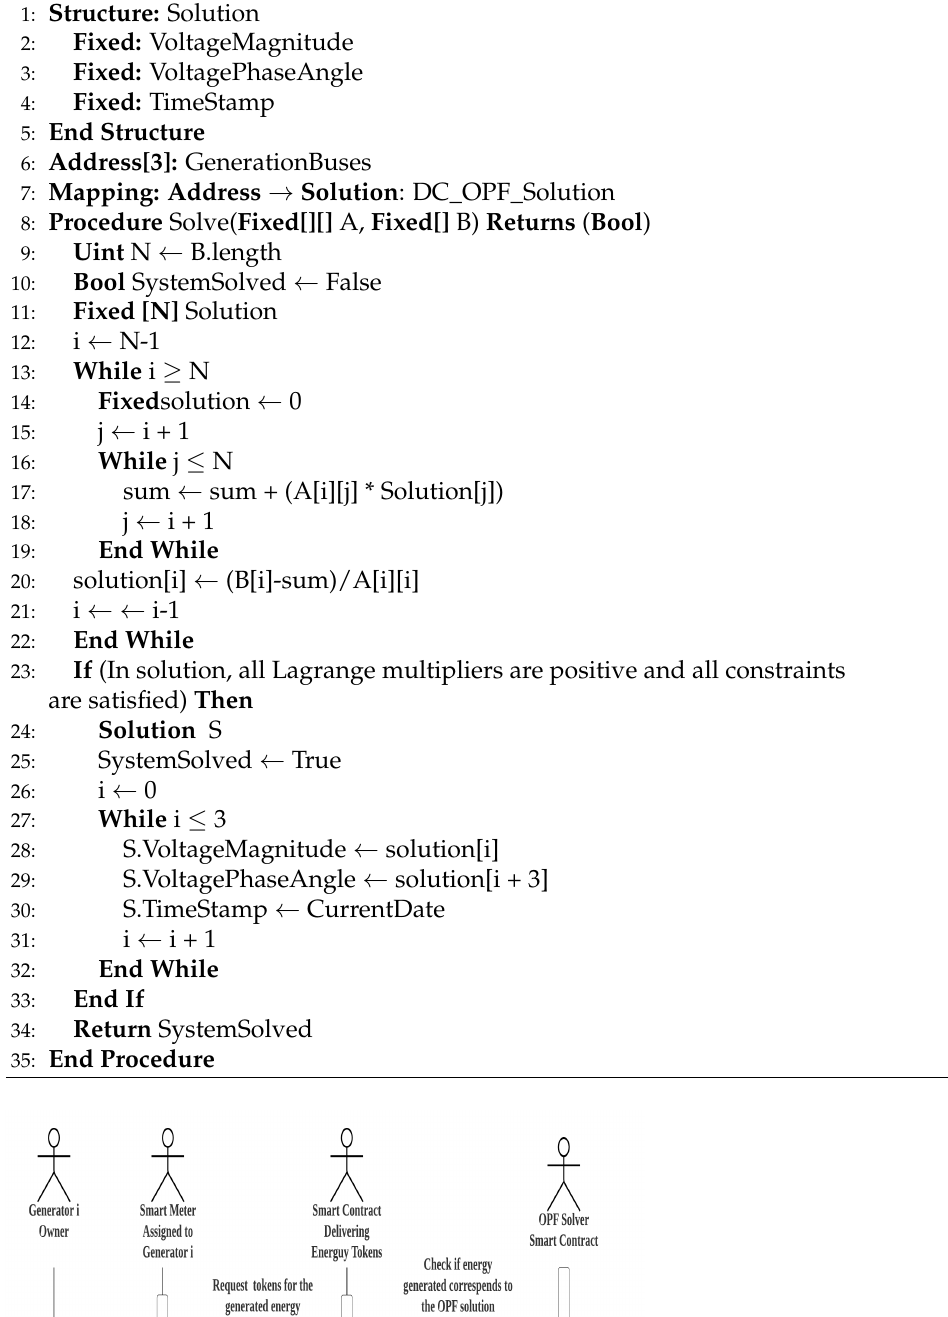
Algorithm 5 OPF Solver Smart contract: Solve row reduced DC-OPF system of linear equations